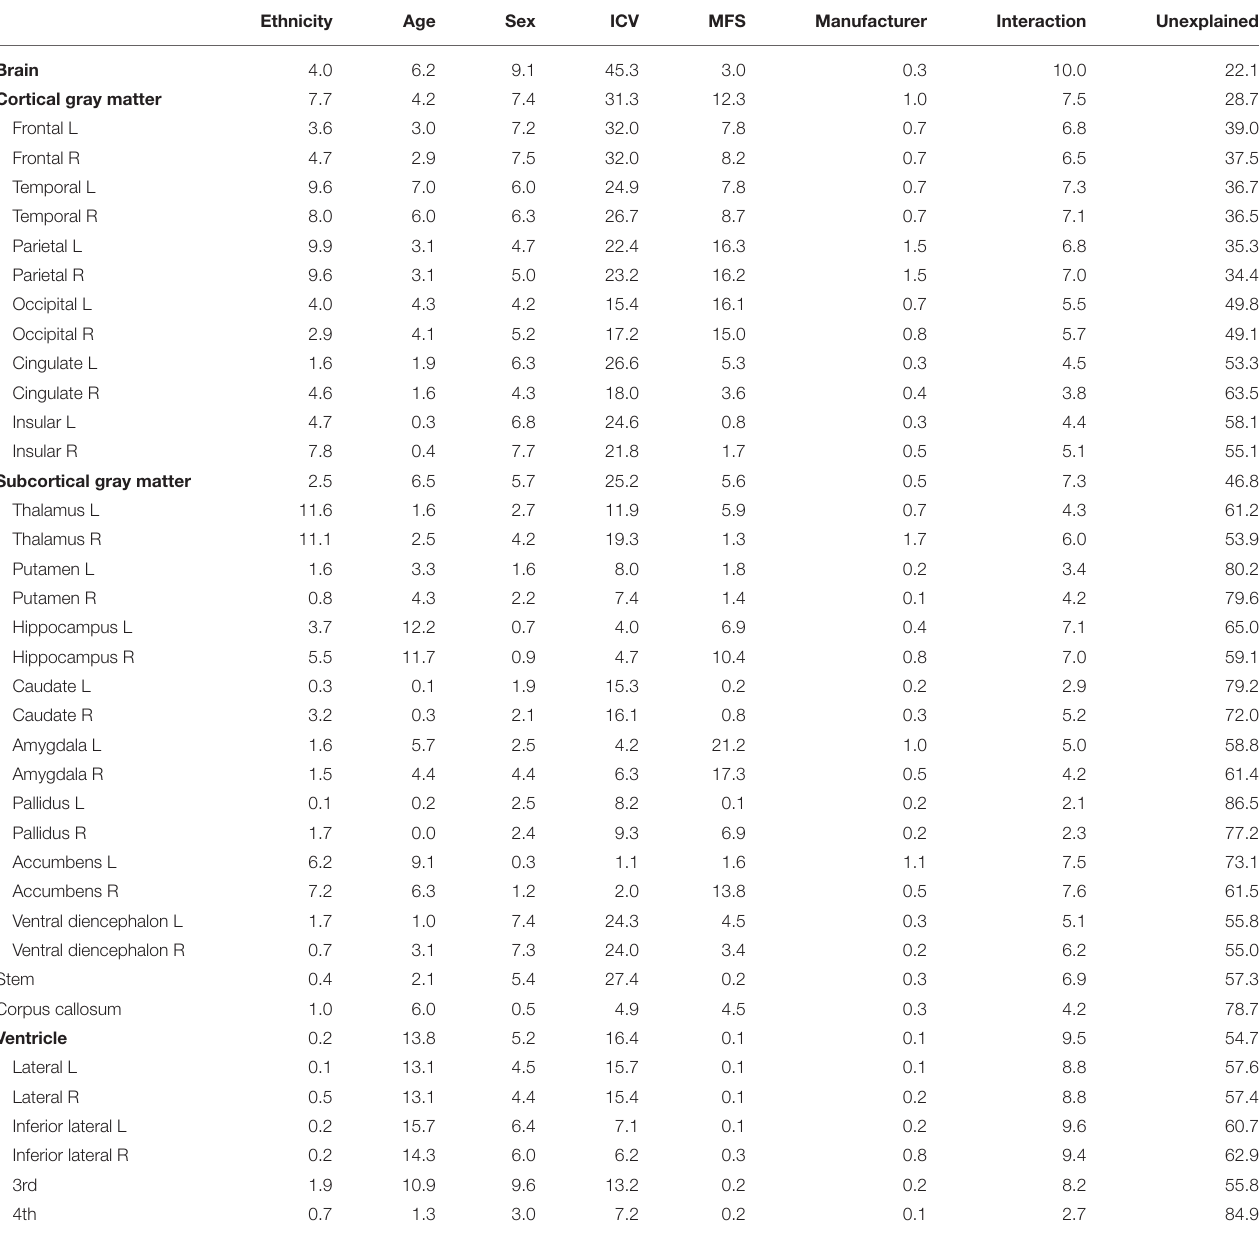
TABLE 3 | Percentage of the variance explained by each predictor in models predicting lobar and subcortical regional volumes. Ethnicity Age Sex ICV MFS Manufacturer Interaction